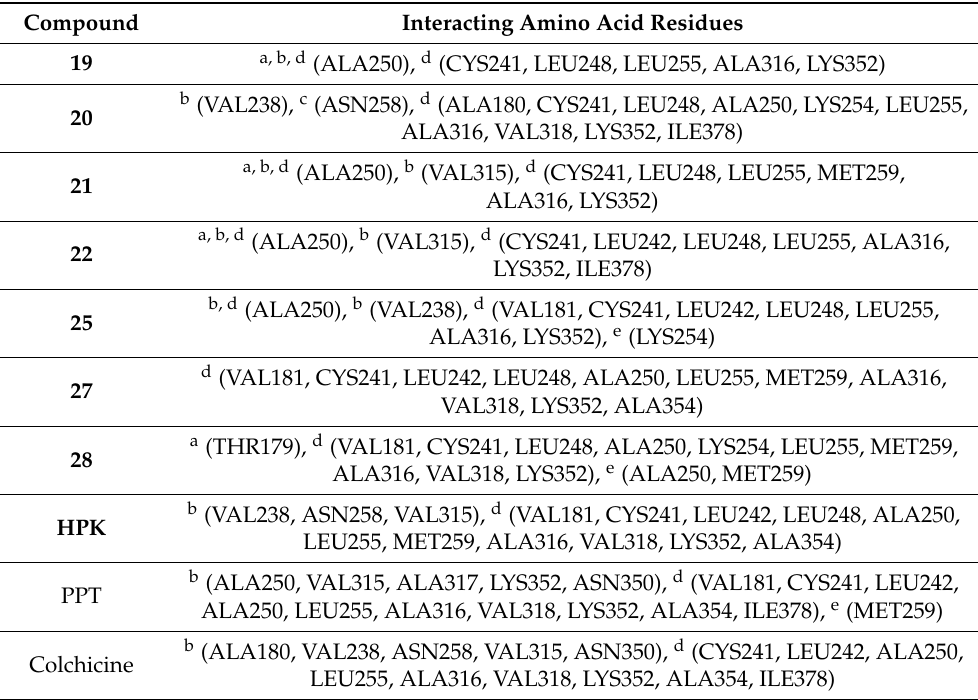
Table 5. The protein–ligand interaction analysis of the synthesized 4-PQ compounds and reference drugs are shown in the colchicine-binding site of the tubulin